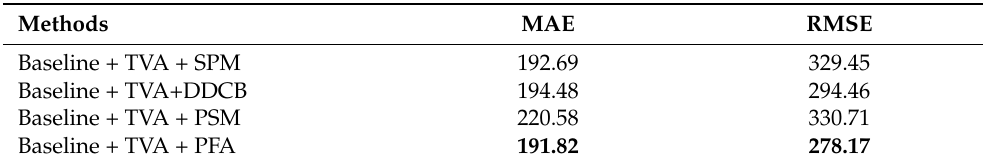
Table 6. Comparative results of different multiscale feature fusion mechanisms on the ship dataset. The best performances are highlighted in bold